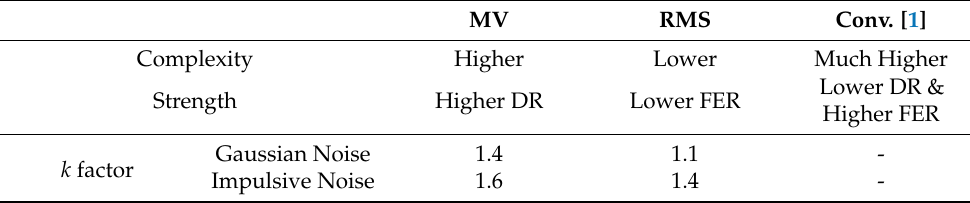
Table 3. Comparison of PQD